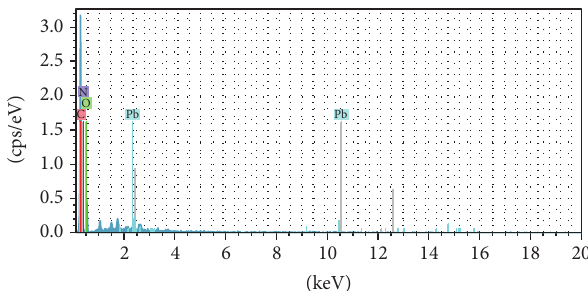
Figure 10: EDX measurement of cross-linked starch xanthate that absorbed Cd 2+